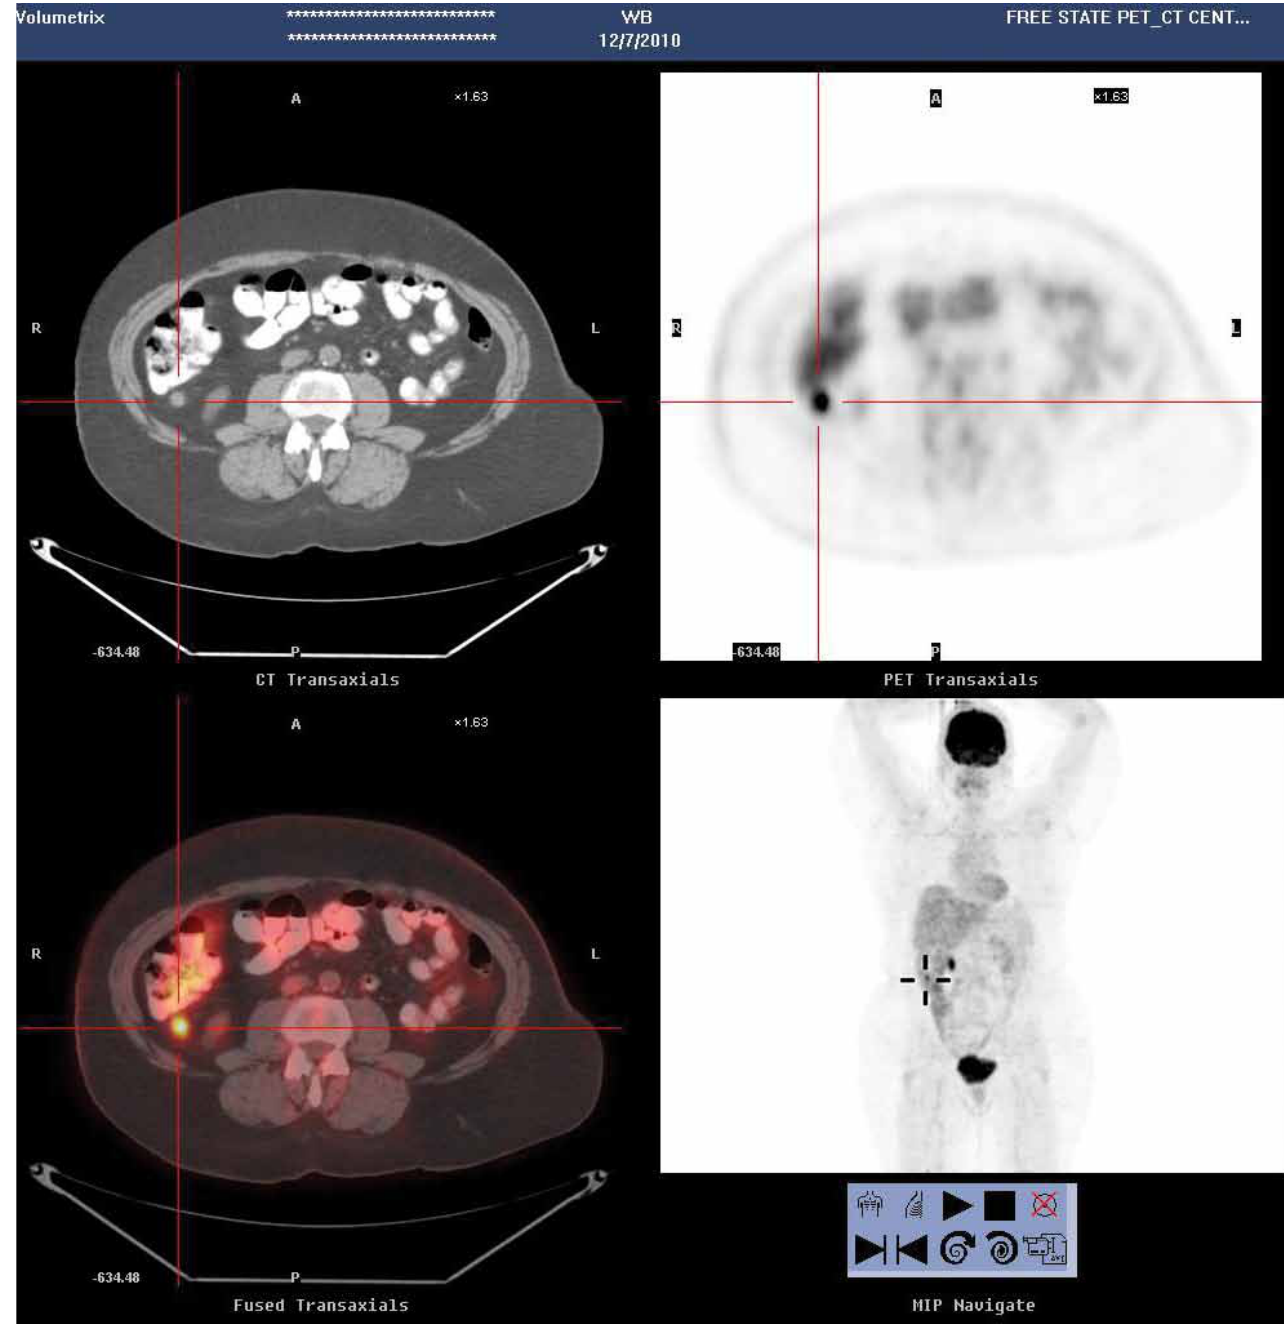
Fig. 1. Transaxial CT, PET and fusion images with the FDG-avid nodule in the tip of the